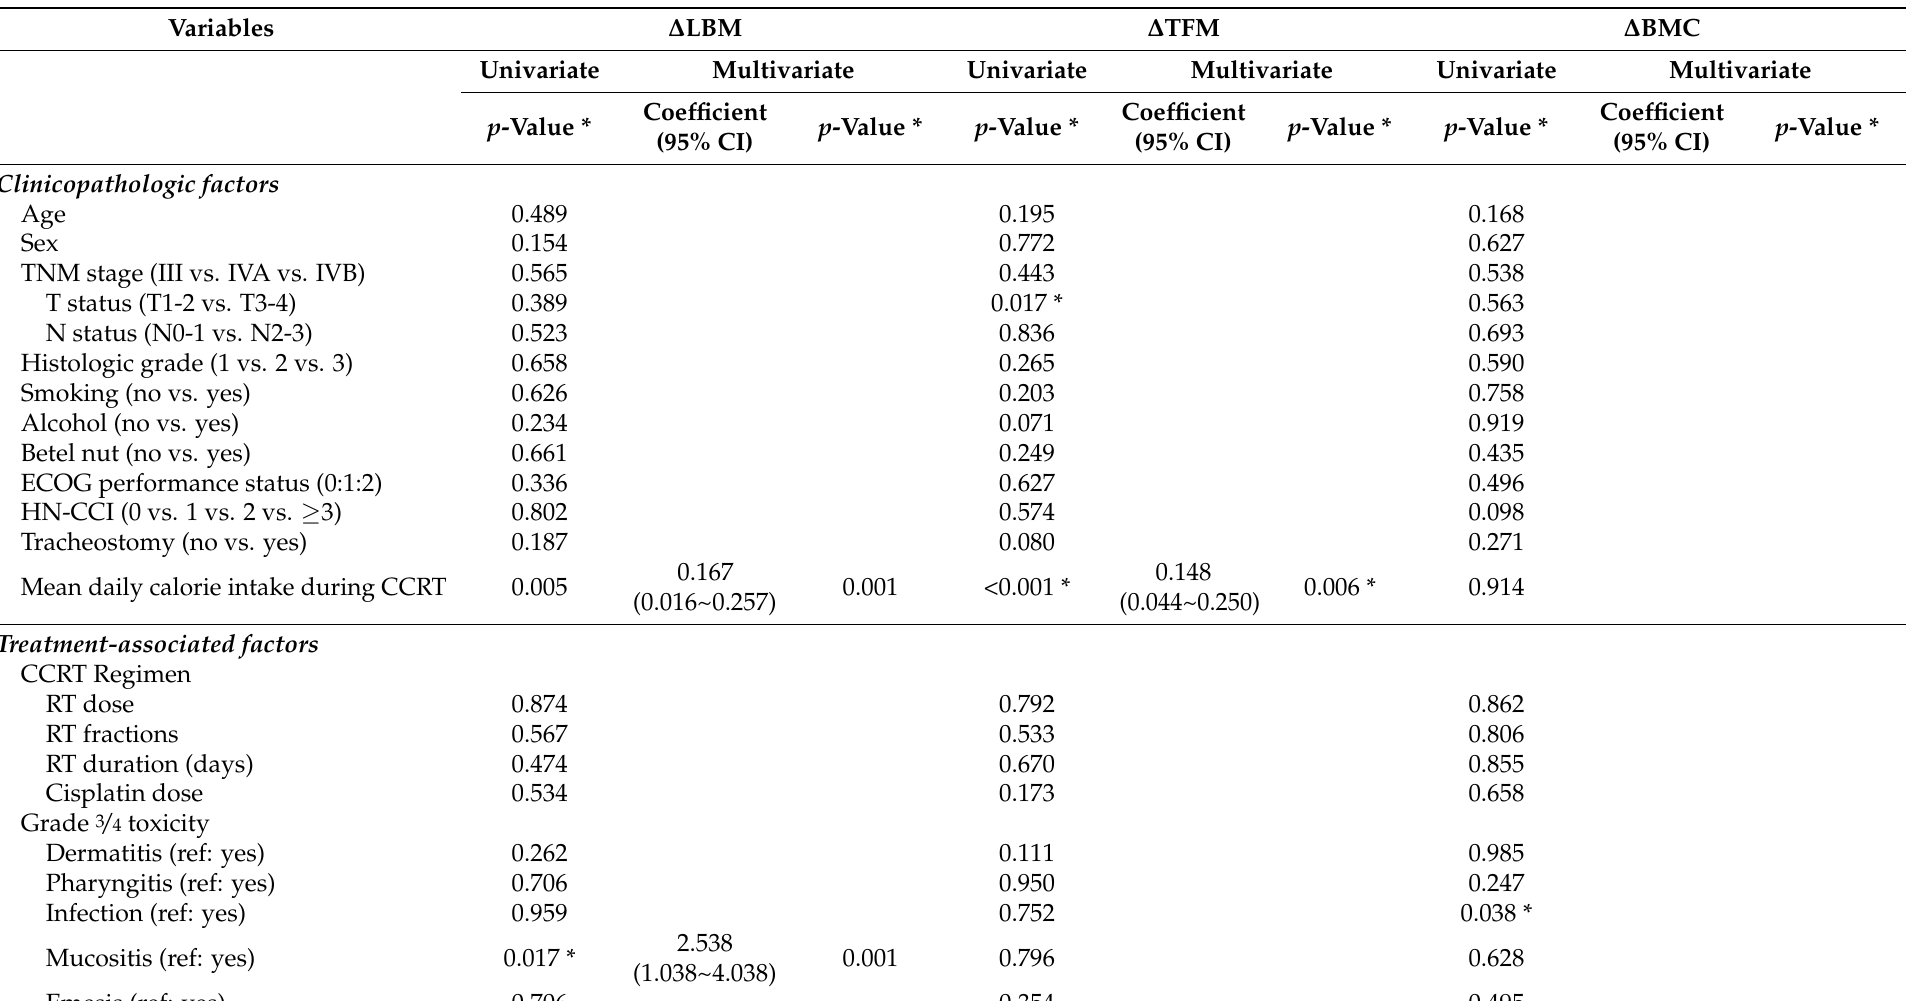
Table 4. Univariate and multivariate associations of clinicopathologic variables, treatment-related factors, nutritional and inflammatory markers with changes of body composition parameters over the CCRT course in 58 patients with non-oral cavity cancer undergoing primary